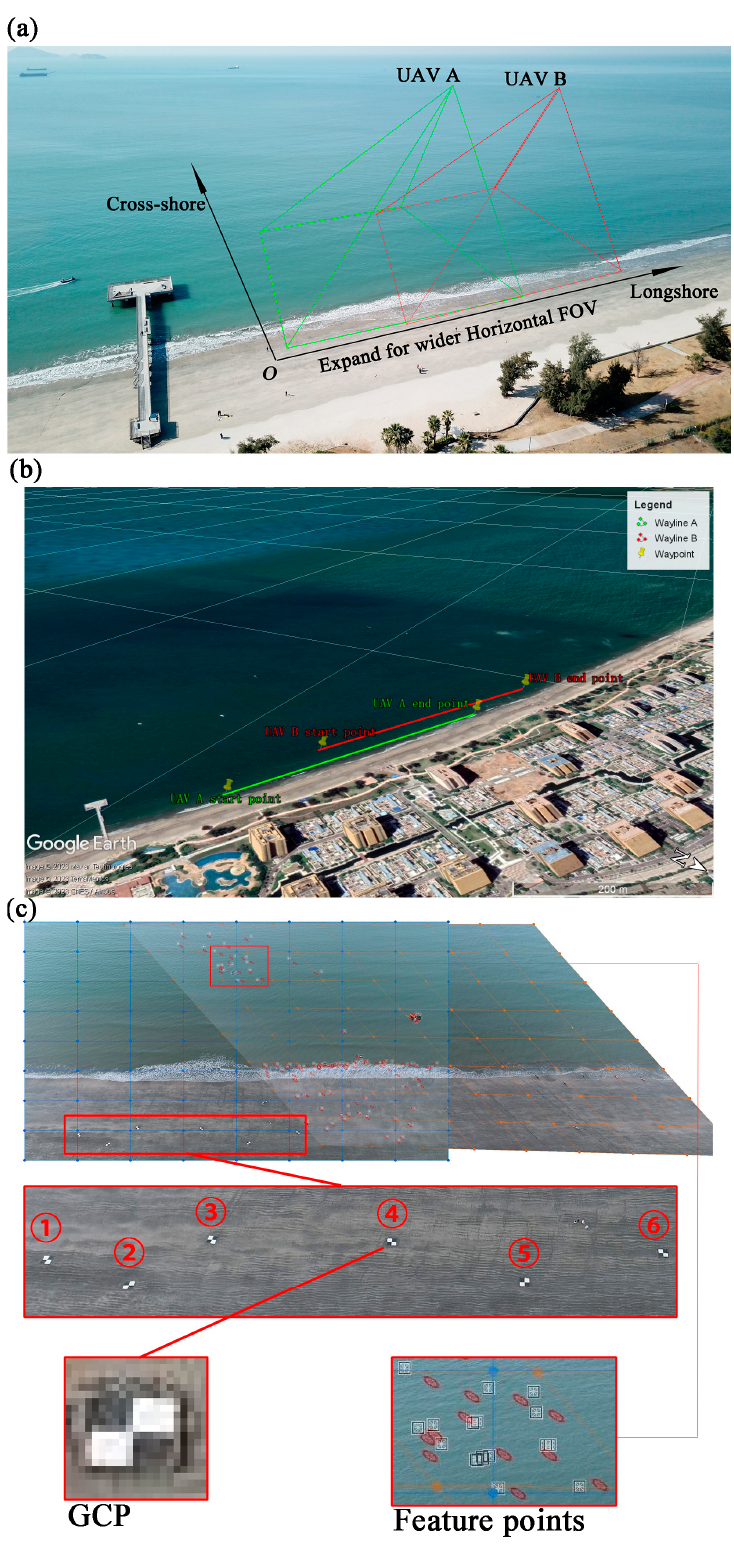
Figure 5. Schematic diagram of flight routes. ( a ) Planning two UAVs to create a wider horizontal FOV. ( b ) The flight routes of the two UAVs. ( c ) The panoramic results of stitching with grids. We placed six GCPs on the beach. The white squares and the red circles are the feature points of the left and right videos,